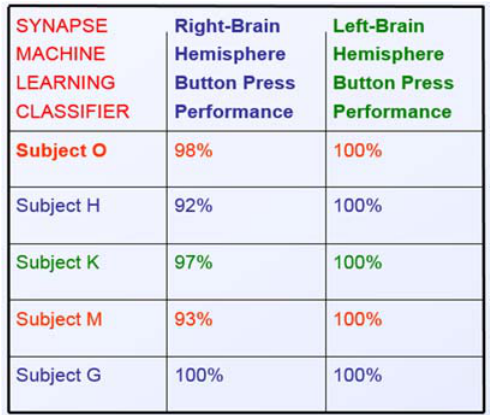
Figure 9. Five Subject’s